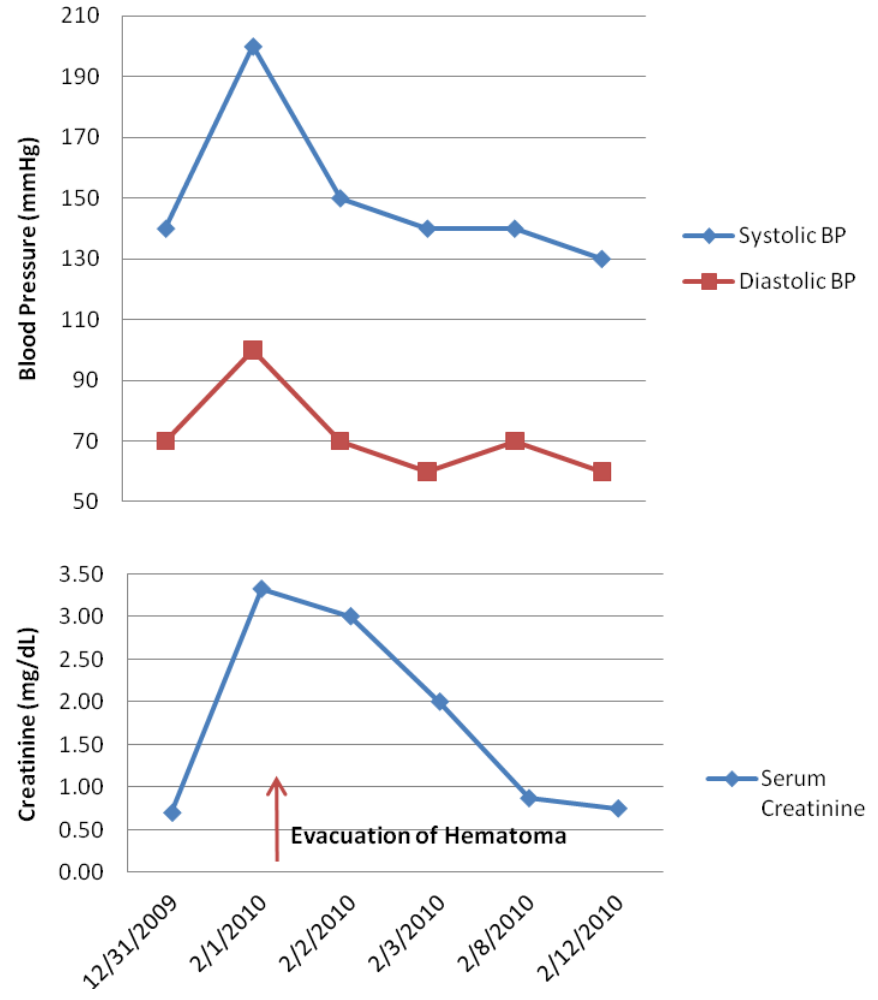
FIGURE 2. Blood pressure and creatinine before and after the kidney biopsy and subsequent evacuation of the kidney hematoma on an emergency basis on the evening of